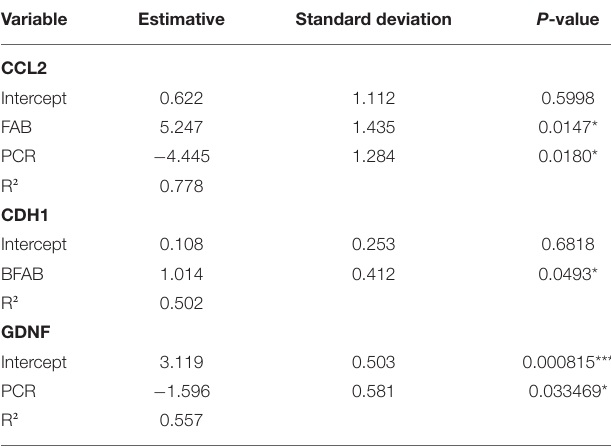
TABLE 2 | Linear regression between M. leprae PCR and AFB values against the global gene expression.